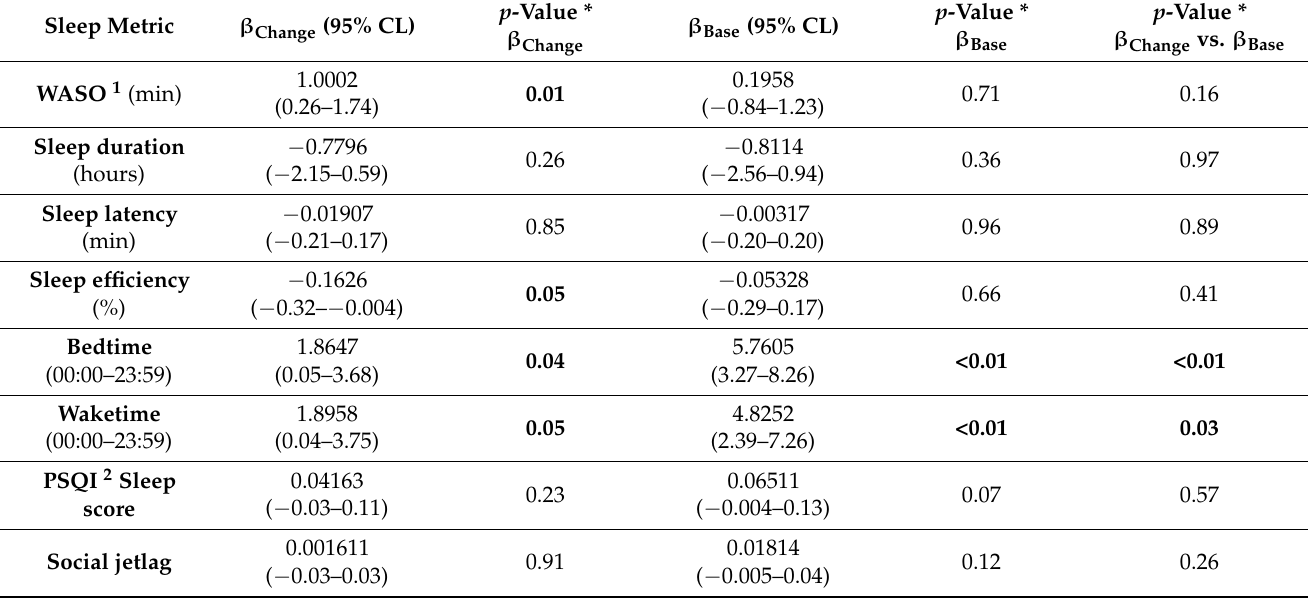
Table 3. Longitudinal changes and baseline effects of sleep metrics from dietary inflammatory